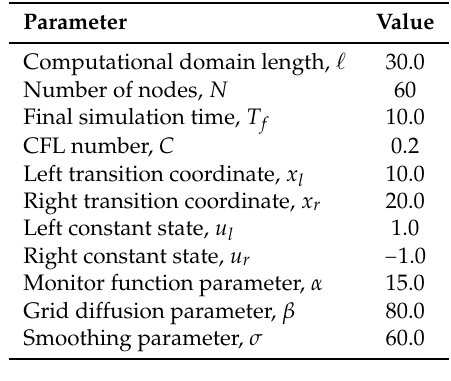
Table 3. The numerical parameters used to simulate a stationary shock-wave formation under the Burgers–Hopf equation dynamics.